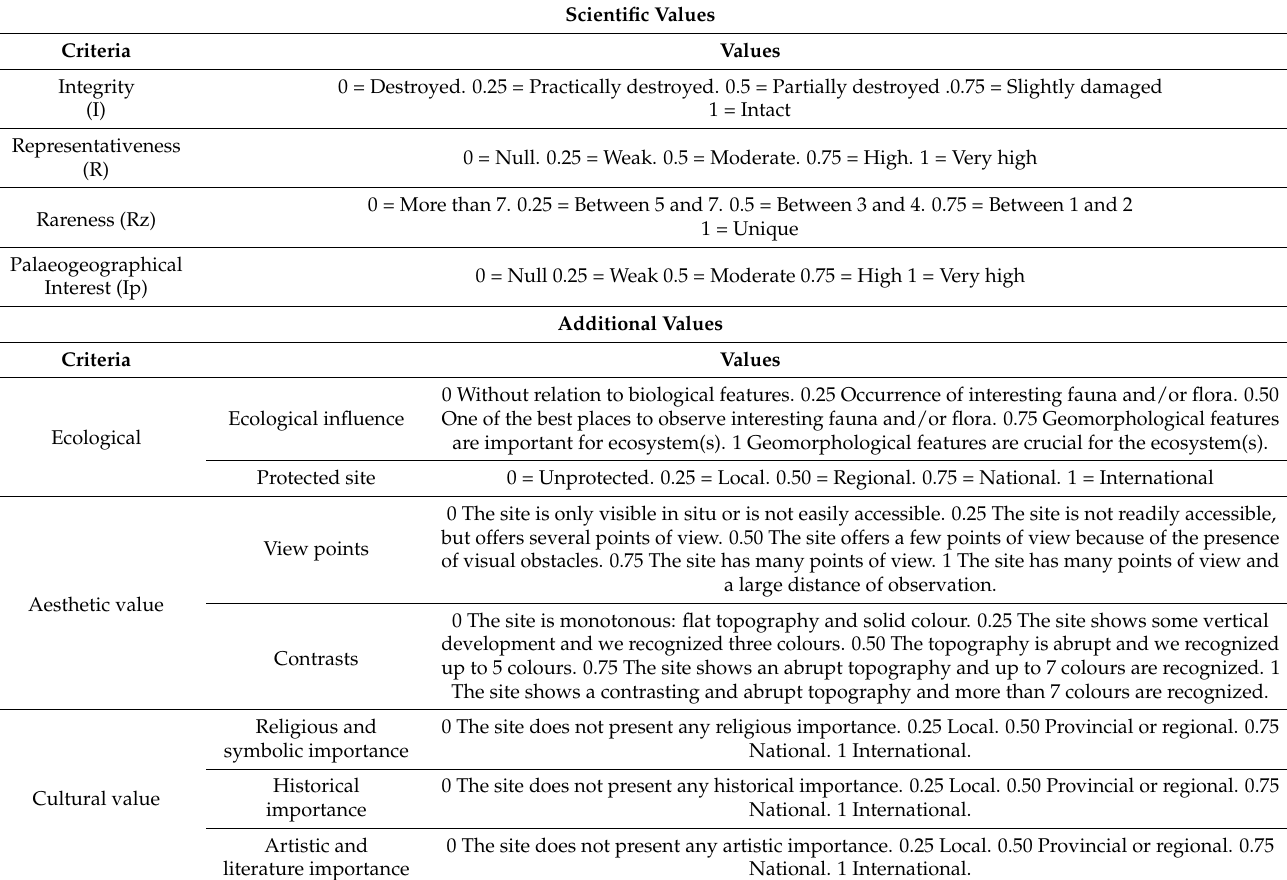
Table 1. Criteria used for the assessment of the scientific value and additional values. Adapted from Reynard et al., 2007; 2016 [44,46] and Bouzekraoui et al., 2017 [47]. Scientific Values